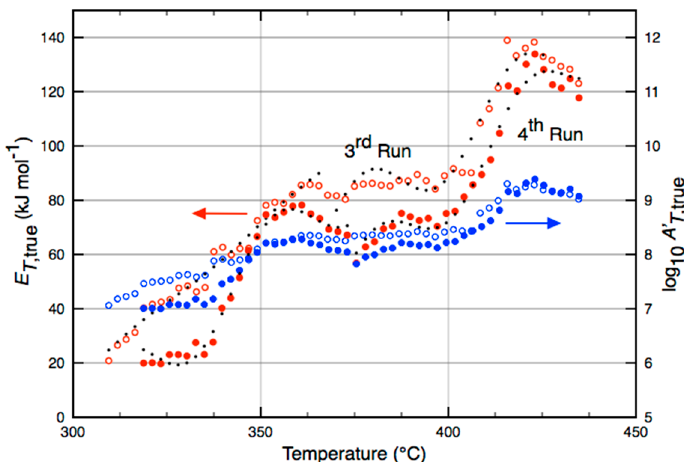
A (cid:48) (blue circles) (cid:1827) (cid:3021),(cid:2930)(cid:2928)(cid:2931)(cid:2915)(cid:4593) (blue circles) T ,true 10 10